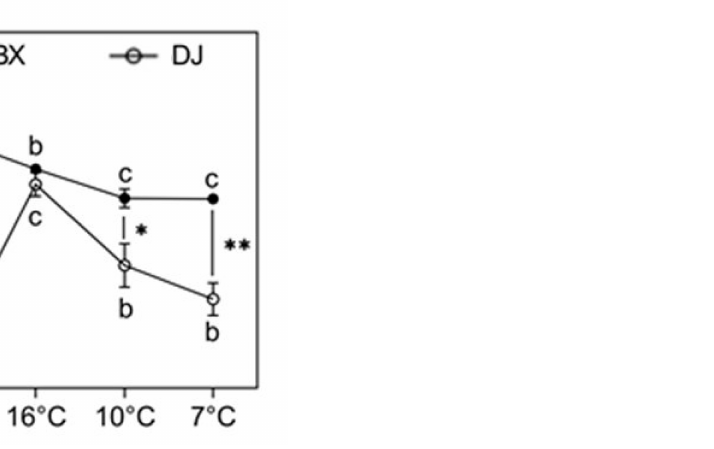
Figure 1. Changes in the hemicellulose content of banana ( Musa spp.) under low temperature stress. Hemicellulose content is expressed as a percentage per gram of fresh leaves. The data represent an average of three replicates ± SE. Values followed by the same letter are not significantly different using a Duncan’s multiple range test at p < 0.05 after angular transformation of the data for each cultivar. Values marked with a star were considered significant at p < 0.05, while values marked with two stars were considered significant at p < 0.01 when evaluated using Student’s t -test. BX